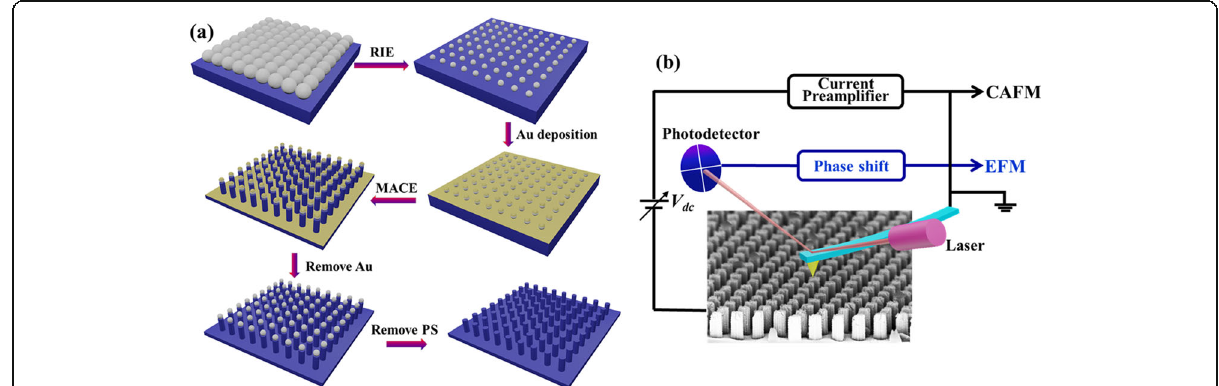
Fig. 1 a Schematic illustration of the procedures to fabricate vertically aligned Si nanowire array. b Schematic diagram of the experimental set- ups for CAFM and EFM measurements on individual Si